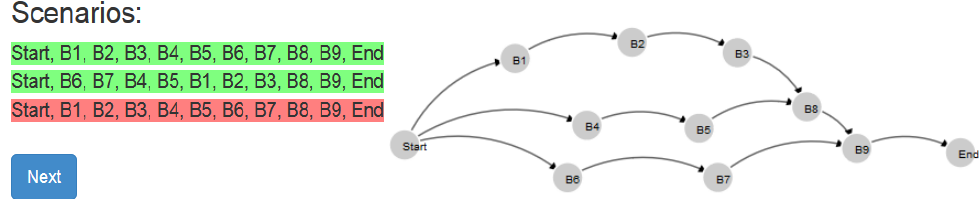
Figure 15. The final model of a demonstrative process example obtained by performing according to Strategy 1.